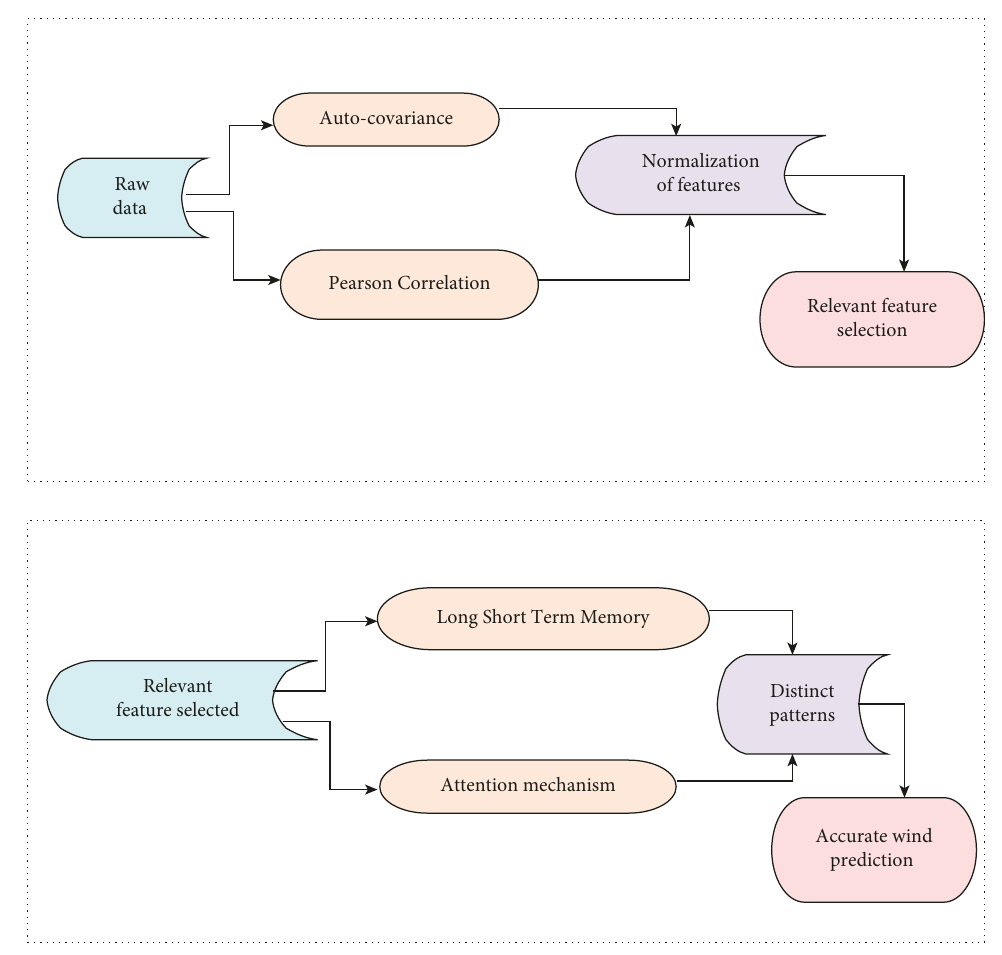
Figure 1: Block diagram of the Pearson Autocovariance Distinct Patterns and Attention-based Deep Learning (PACDP-ADL) for wind power